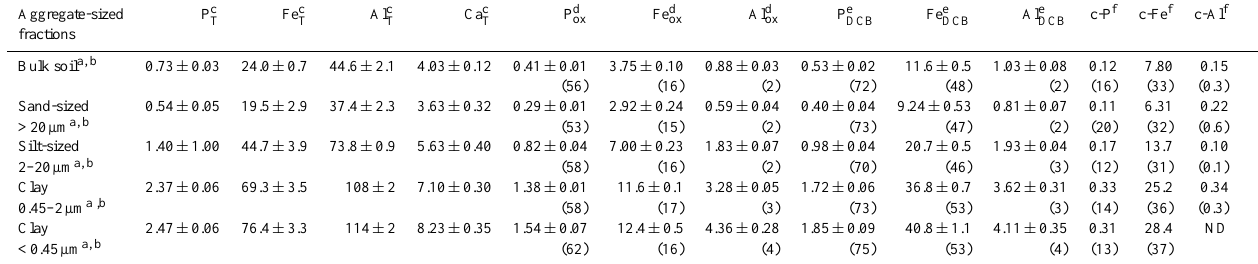
Table 2. The amounts of P, Fe, Al and Ca in bulk soil and soil aggregate-sized fractions, and the amounts of these elements extracted by oxalate and dithionite–citrate–bicarbonate (DCB) (gkg − 1 ) . Fractions with respect to total P, Fe, and Al values of each aggregate-sized fraction shown in Table 2 are given in parentheses. Data are the mean values of three replicates with standard deviations. Aggregate-sized P c T Fe c